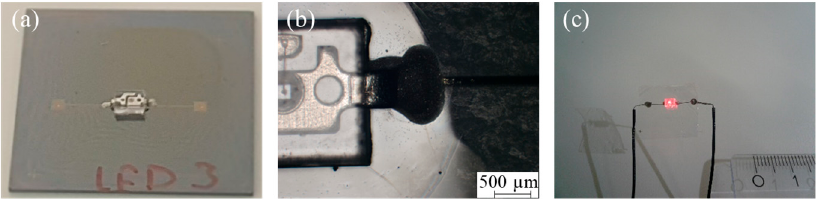
Figure 8. Photo of the silicon chip with printed contacts and mounted LED before Parylene deposition ( a ) as well as front side light microscopic image of the LED contacts ( b ). Photo of the lifted LED on the flexible Parylene substrate when applying a voltage ( c ). The setup corresponds to Figure 1 (column (c) and line (7)).